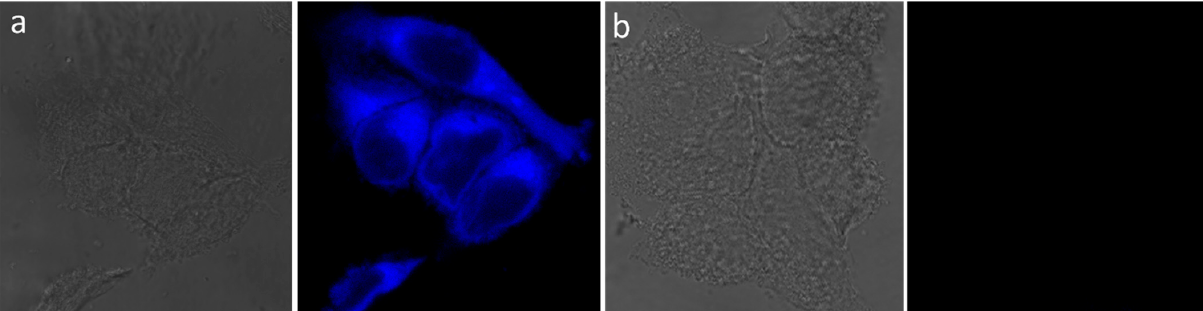
Figure 10. Nomarski interference contrast (NIC) and confocal laser scanning microscopy (fluores- cence) images of HeLa cells stained with 4,5-bis(arylethynyl)triazole 5d ( a ); control cells ( b ). Cells were incubated for 1 h in media containing10 μ M of 5d .